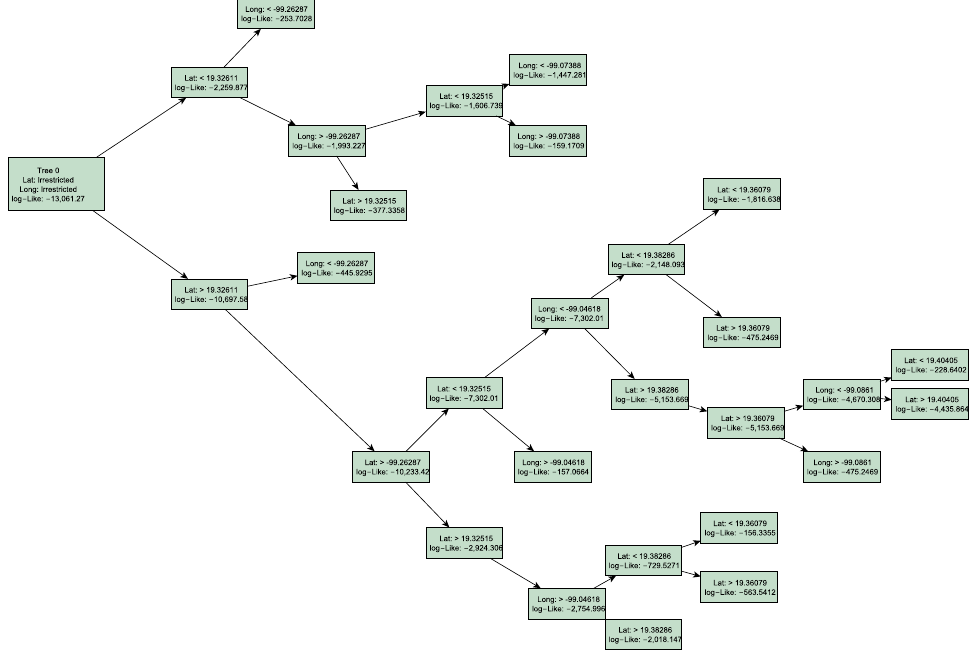
Figure 5. Branching rules obtained to form the decision tree of the GEV distribution parameters of the PM2.5 maxima in the Mexico City metropolitan